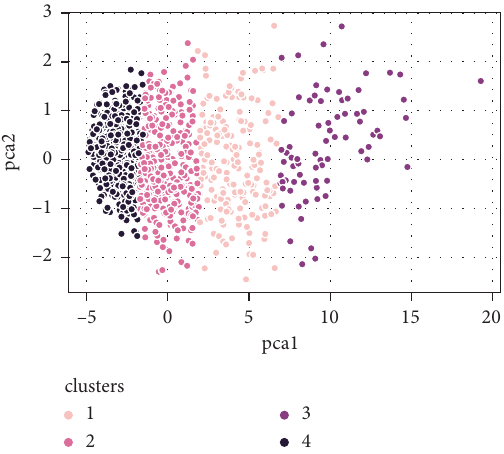
Figure 8: K-means clustering for Scenario 2.